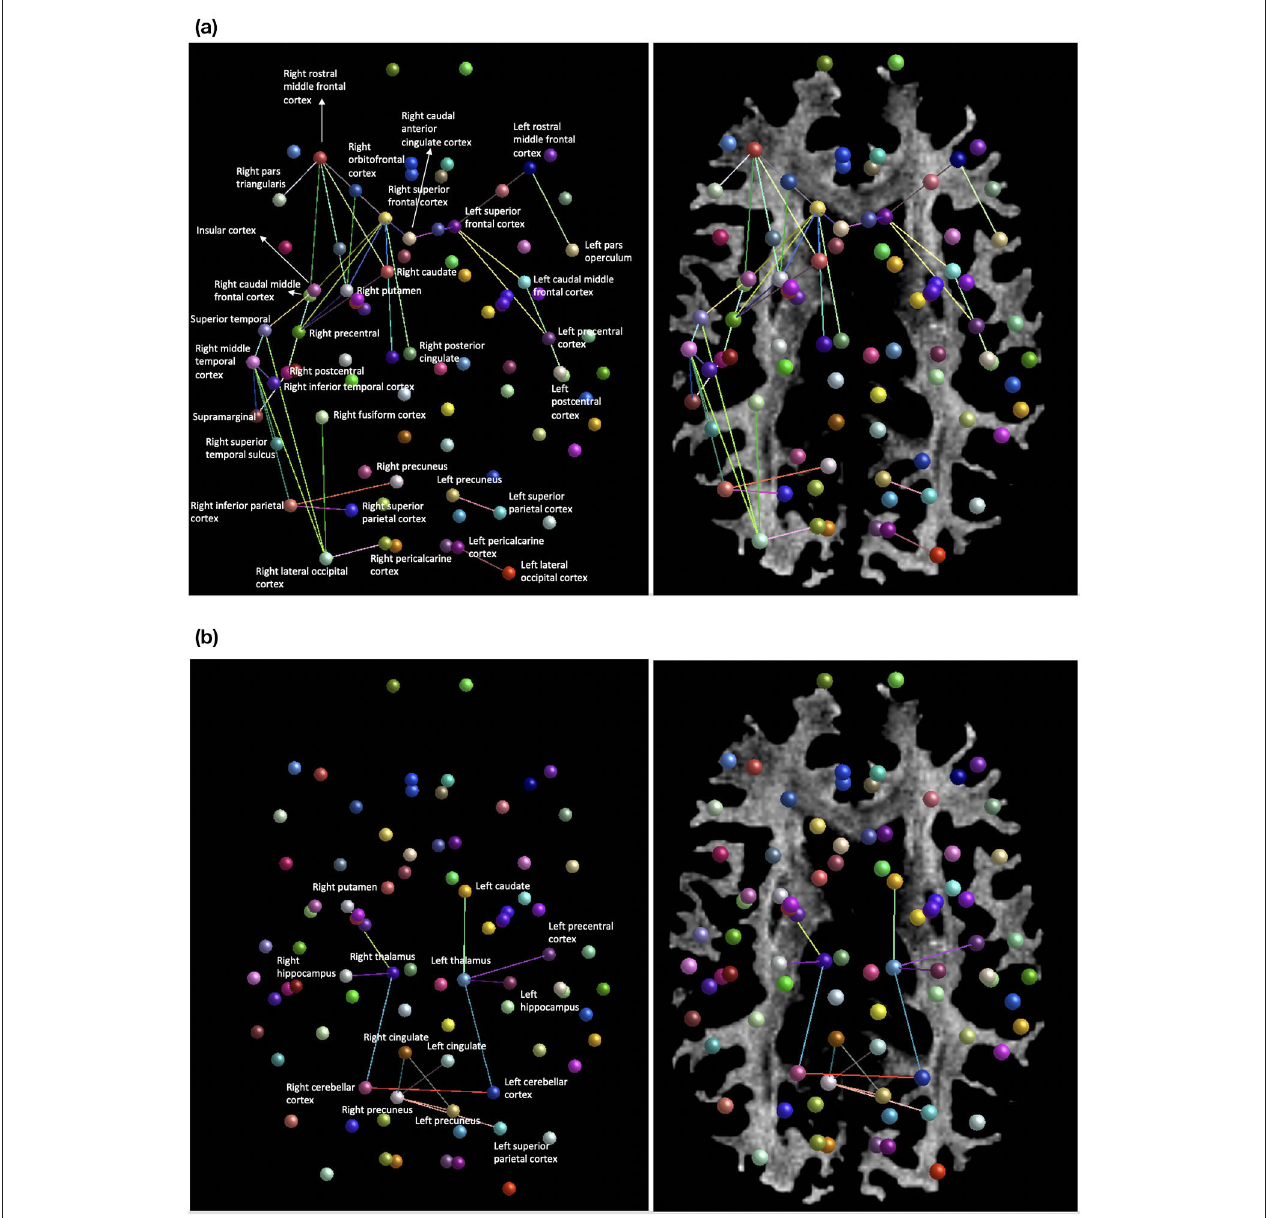
FIGURE 3 | (a) Areas of decreased connection density of the structural network mean post-injury compared to mean pre-injury. (b) Regions of increased connection density of the structural network mean post-injury compared to mean-pre-injury.